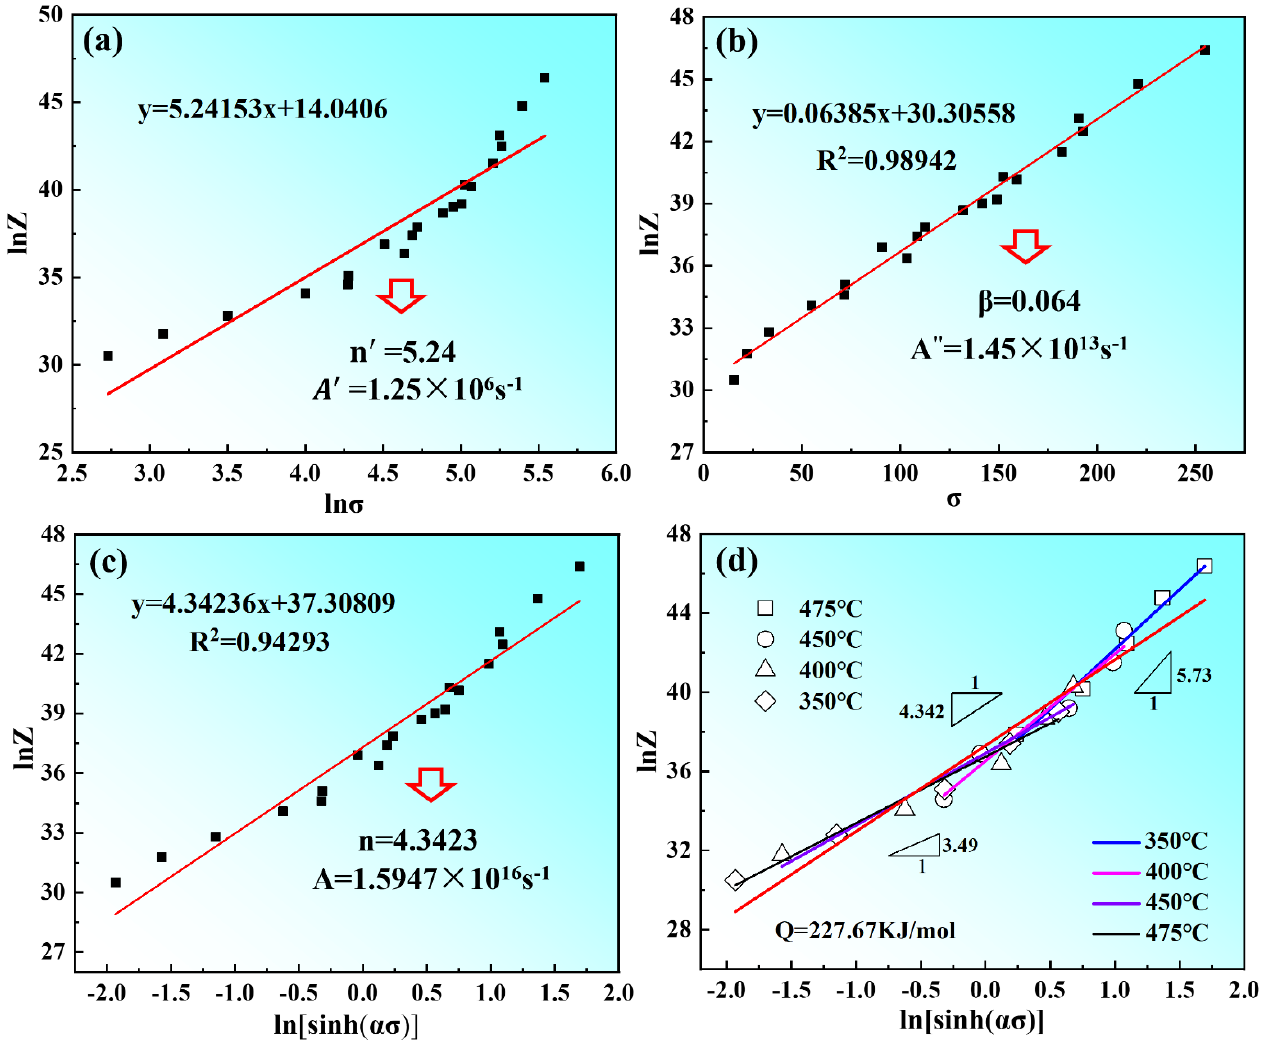
Figure 9. The linear relationships between ln Z and ln σ ( a ); the relationship between ln Z and σ ( b ); the relationship between ln Z and ln[sinh( ασ )] ( c ); linearization of ln Z -ln[sinh( ασ )] data showing the low-stress region and high-stress region with a stress exponent of 3.49 and 5.73, respectively ( d ).